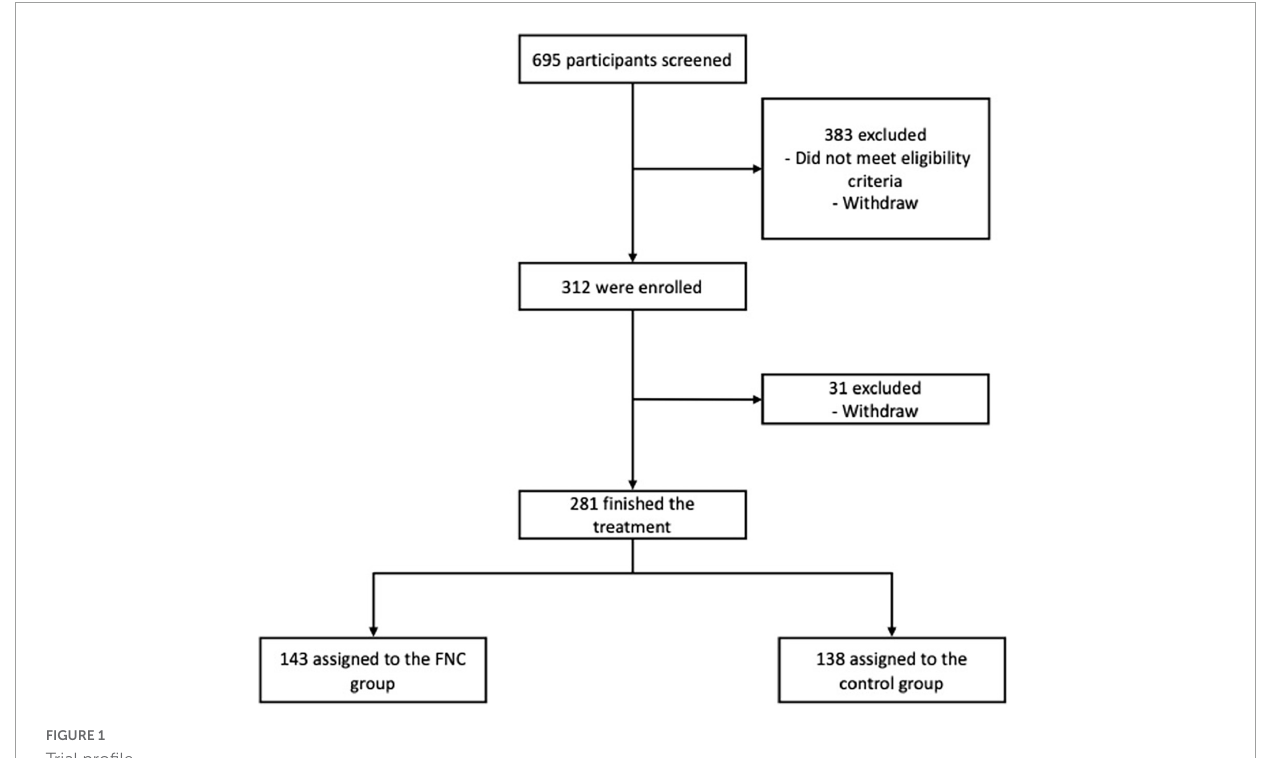
FIGURE1 Trial profile.